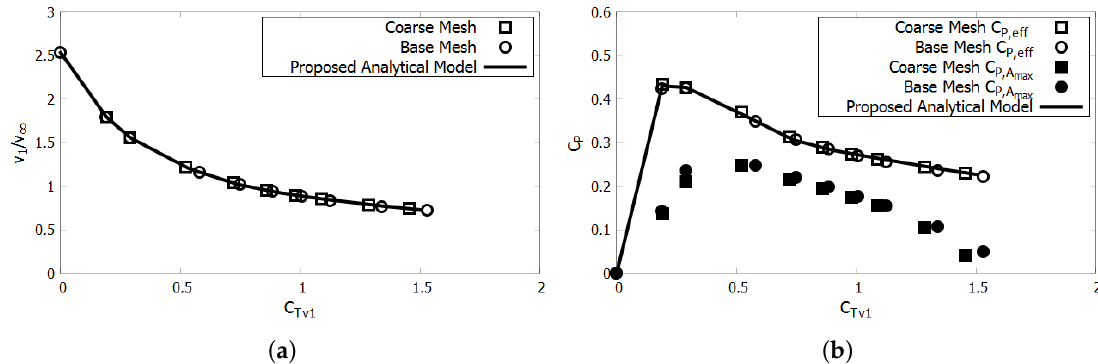
Figure 11. Analytical model and ducted CFD predictions with calibrated velocity. ( a ) v 1 / v ∞ vs. C Tv ( b ) C P vs. C Tv 1